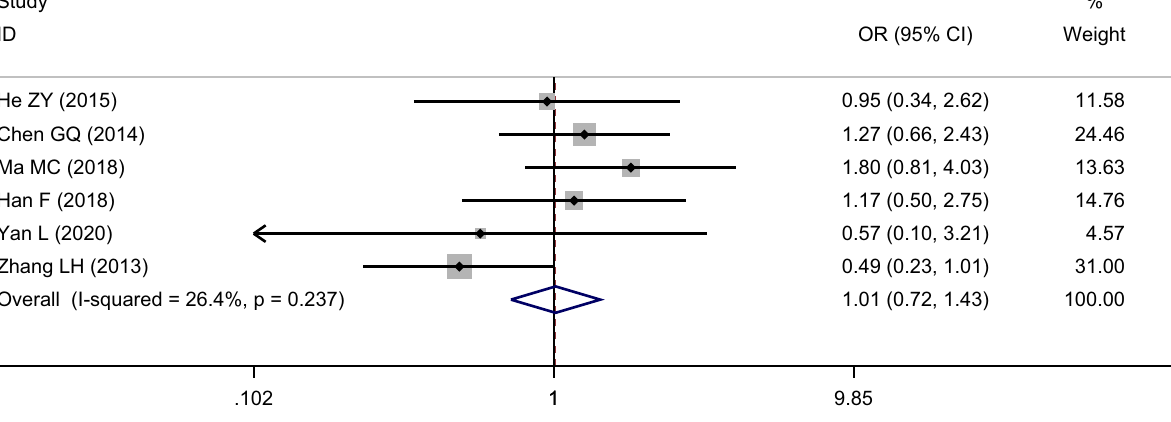
Figure 3: Forest fi gure of relationship between the expression of SIRT1 and di ff erentiation of ESCC.